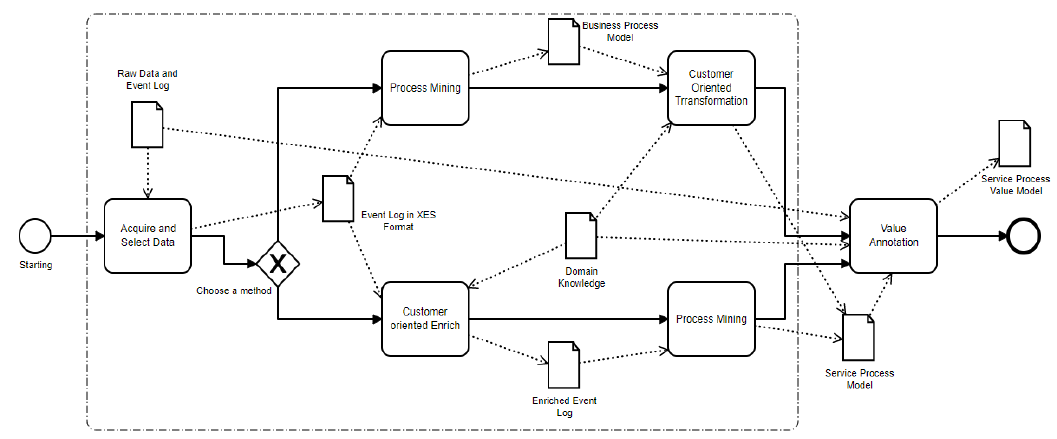
Figure 3. Modeling based on process mining.